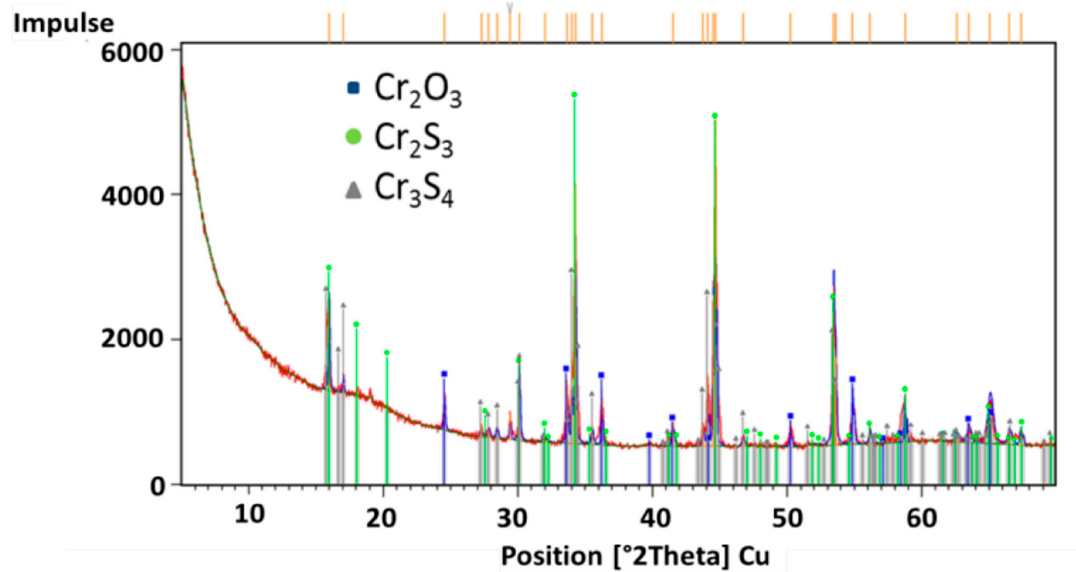
Figure 7. XRD diffraction pattern of corrosion products formed on S31400 and N06600 at 680 °C. [19].